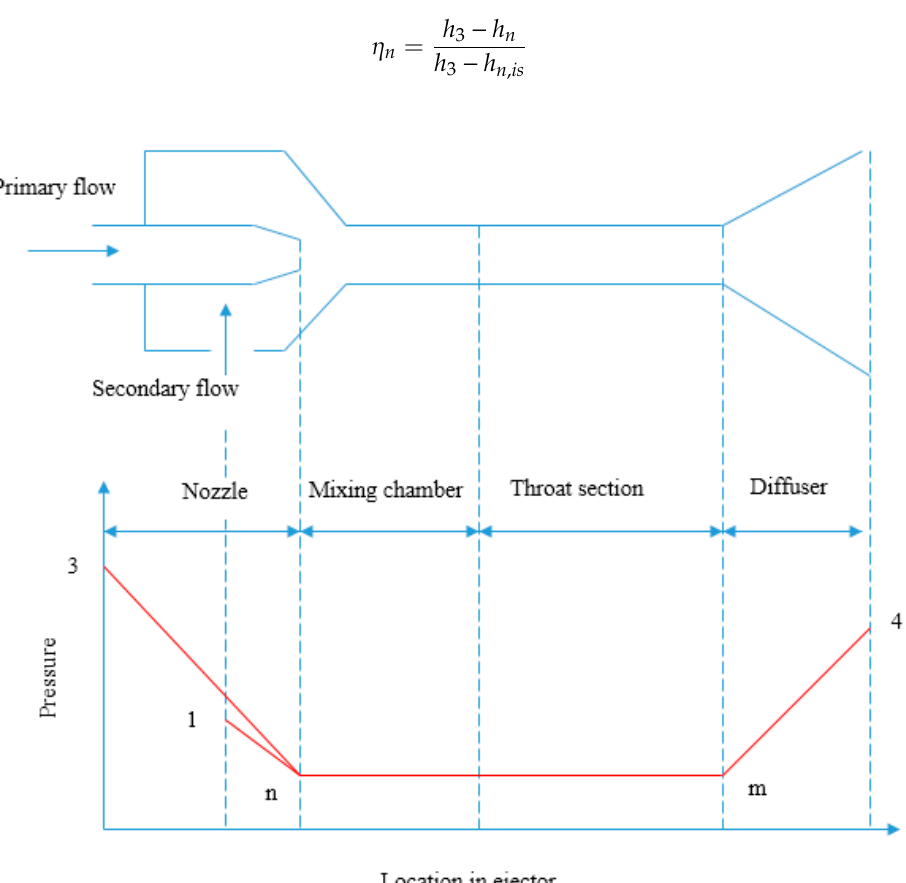
Figure 3. The ejector schematic with pressure variation.